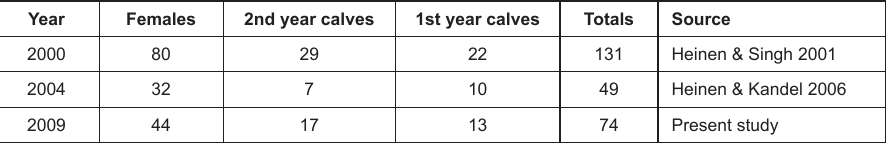
Table 5. The number of backcrossed buffalo counted in KTWR. The number greatly decreased in 2004 compared to 2000 as a result of a shooting campaign. The Army began shooting buffalo of domestic origin in 2001. By March 2004, 167 buffalo had been shot inside the reserve (source: Reserve records 2005). However, this policy was controversial because some illegally grazed domestic animals were killed and the Army has since halted the culling. As a consequence, the number is gradually